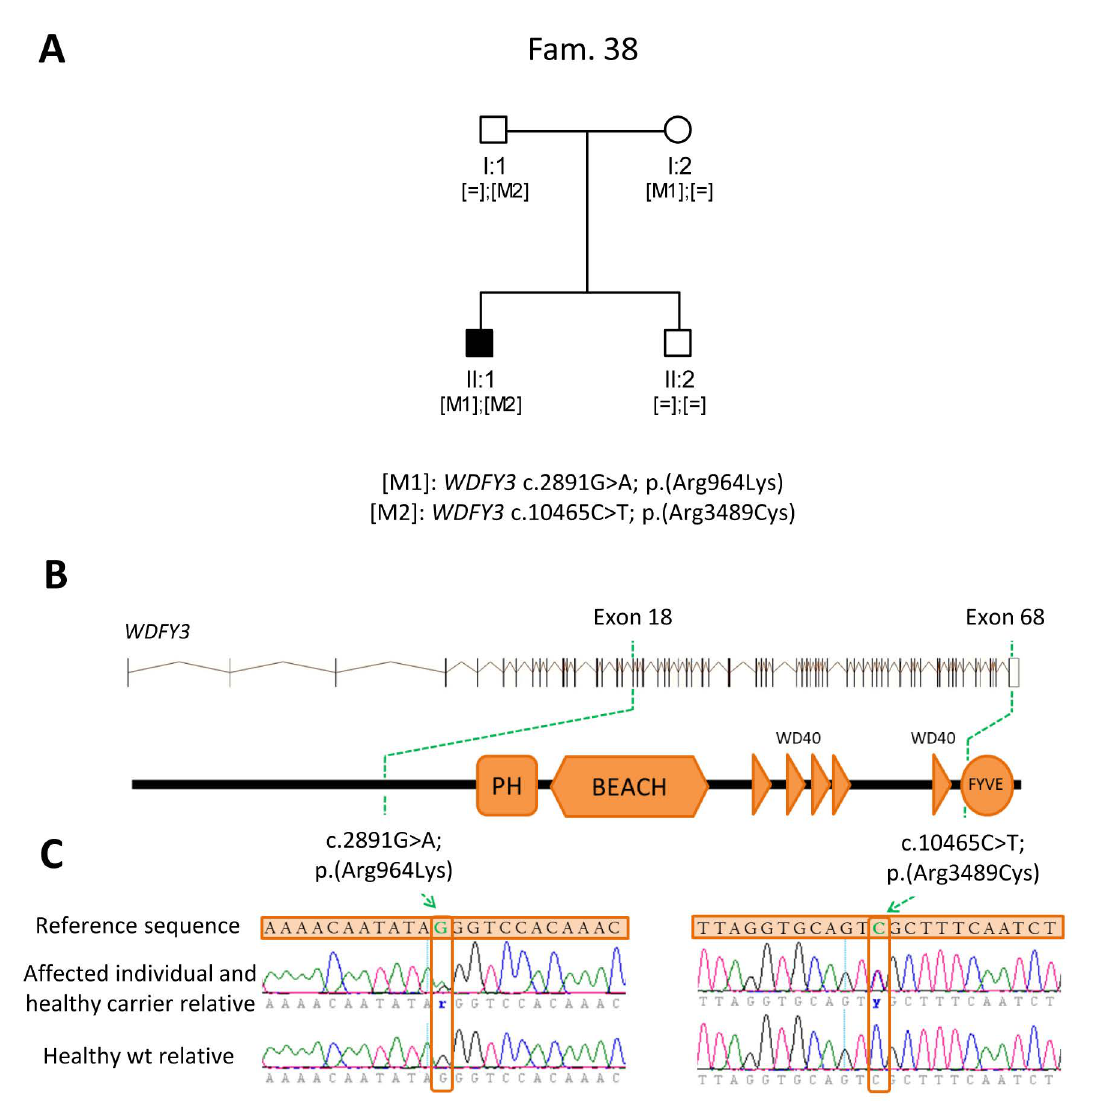
Figure 2. Pedigree of candidate variants detected in Family 38 and schematic representation of the identified WDFY3 mutations. ( A ) Pedigree of Family 38 and segregation study of the detected variants in WDFY3 . ( B ) Genomic and protein location of the segregating variants in WDFY3 (NM_014991), which is composed of 68 exons (vertical lines). The protein depiction was performed according to Uniprot, showing five beta-transducin repeats (WD40) and three di ff erent domains: pleckstrin homology (PH), beige and Chediak–Higashi (BEACH) and Fab1, YOTB, Vac1, and EEA1 (FYVE) zinc finger. The location of the identified mutations is stated with a broken green line. ( C ) Electropherograms illustrating the detected WDFY3 variants in heterozygous state and the wild type